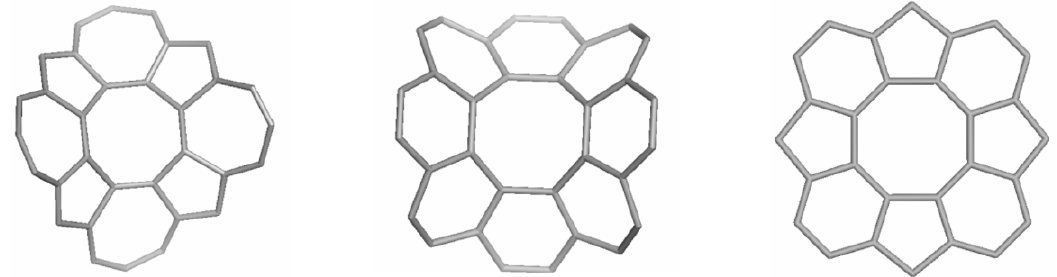
Figure 1. Circulenes 1a [8:(5,7)